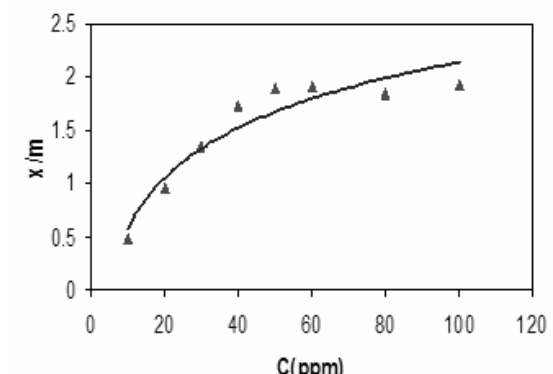
Figure 6. Effect of initial concentration on the removal of lead ion using sawdust (SD) as